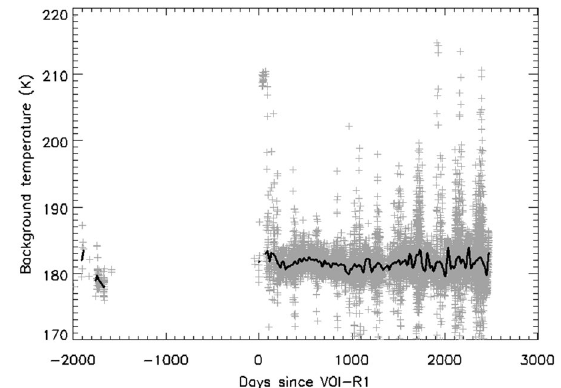
Fig. 3 Sensitivity variation of LIR as a function of the duration of the LIR’s operation, showing observations (gray crosses) and a fitted trend (dashed line). The negative values indicate degradation of sensitivity